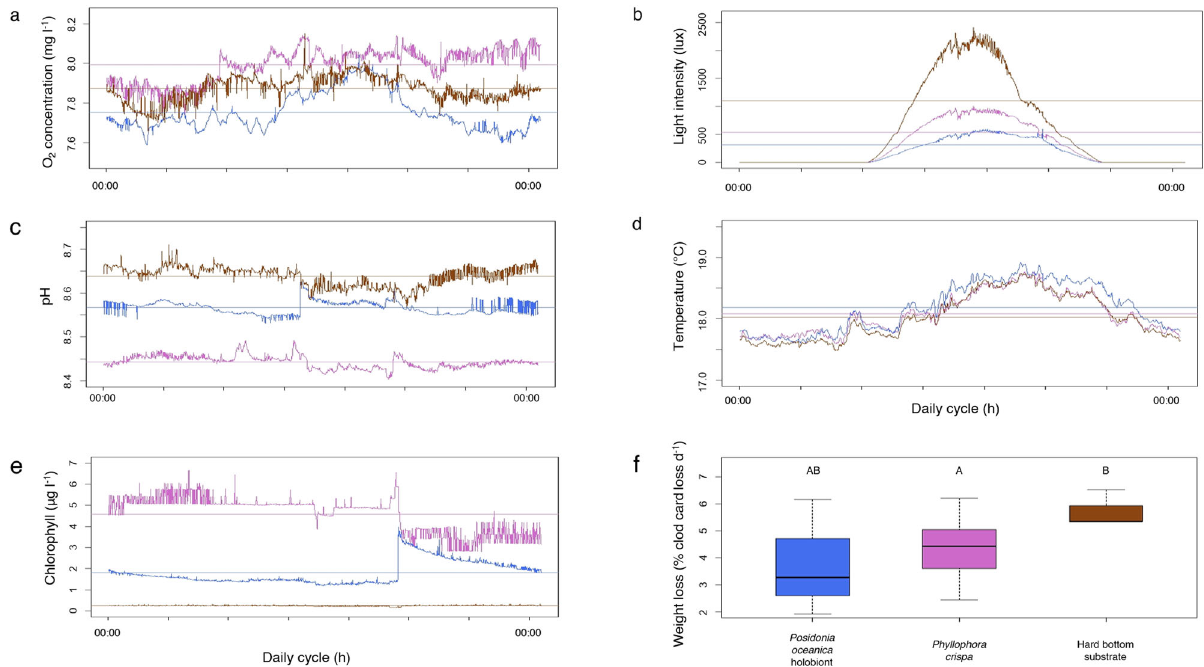
Fig. 4 Environmental parameters measured in Phyllophora crispa and Posidonia oceanica . Environmental data consisting of oxygen (O 2 ) concentration ( a ), light intensity ( b ), pH ( c ), temperature ( d ), chlorophyll a concentration ( e ) and water movement (estimated via weight loss of clod cards; f ) in Phyllophora crispa (purple), Posidonia oceanica (blue) and neighbouring hard-bottom substrate serving as a reference habitat (brown). Horizontal lines within panels a – e display daily mean of respective deployment (with n = 13 for P. crispa , n = 7 for P. oceanica , n = 6 for reference habitat for O 2 concentration, pH and chlorophyll a concentration, and with n = 10 for P. crispa , n = 6 in P. oceanica , n = 4 in reference habitat for light intensity and temperature) of respective parameters in each habitat. Note for panel f : different letters above box plots indicate signi fi cant differences between habitats (ANOVA and subsequent Tukey HSD test), with n = 9 for P. crispa , n = 4 for P. oceanica , n = 2 for reference